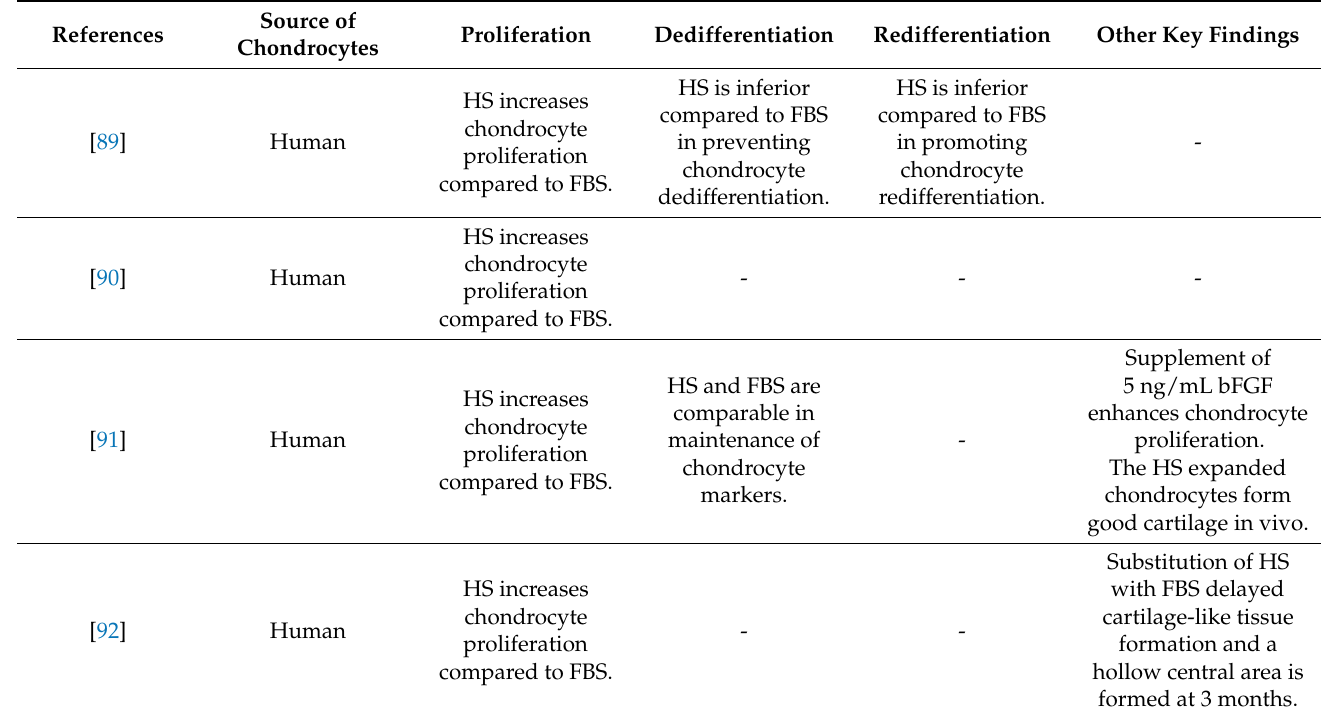
Table 5. Key findings in the studies reported human serum-based chondrocyte